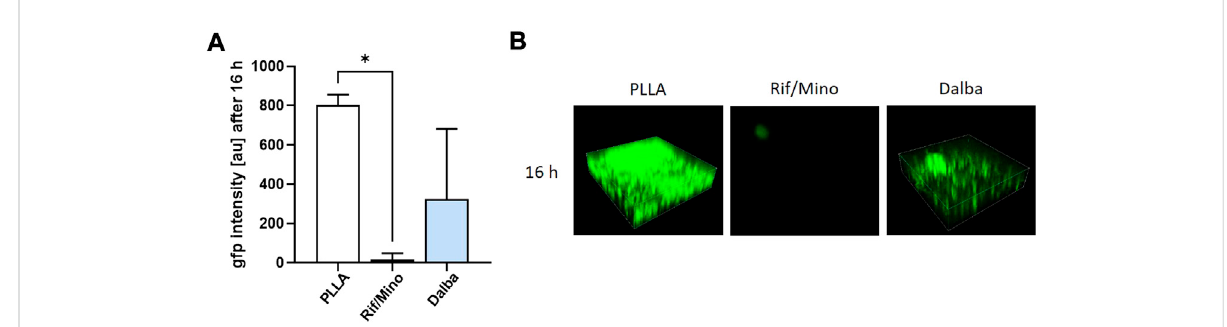
FIGURE 3 Rifampicin/minocycline and dalbavancin inhibit the bio fi lm formation of Staphylococcus aureus FR20. The effectiveness of rifampicin/ minocycline and dalbavancin against Staphylococcus aureus FR20 bio fi lm formation was analyzed in a fl ow system. Inhibition of bio fi lm formation was monitored by (A) measuring green fl uorescent protein (GFP) fl uorescence intensity and (B) confocal laser scanning micoscropy (CLSM) of randomly selected areas (spanning 100 μ m × 100 µm) after 16 h p values < 0.05 were considered signi fi cant. * p < 0.05. Rif/Mino: rifampicin/ minocycline; Dalba: dalbavancin; au: arbitrary